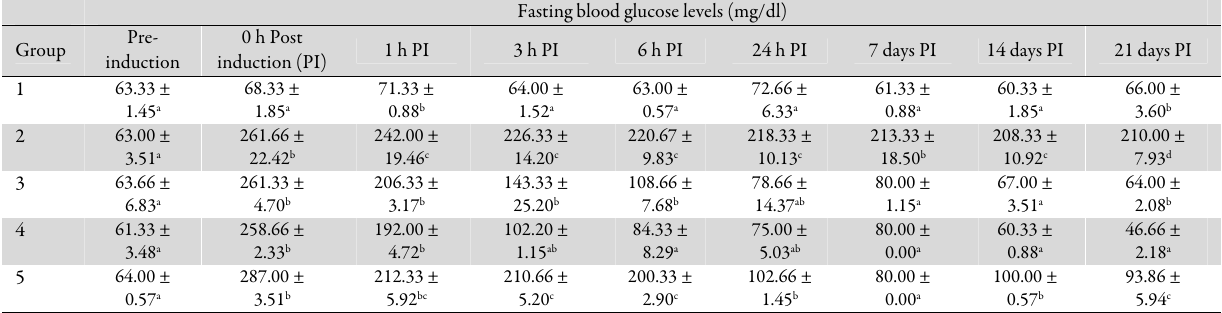
Table 2. Fasting Blood Glucose (FBG) values of alloxan induced diabetic rats treated with combinations of glibenclamide and aqueous extract of G. latifolium